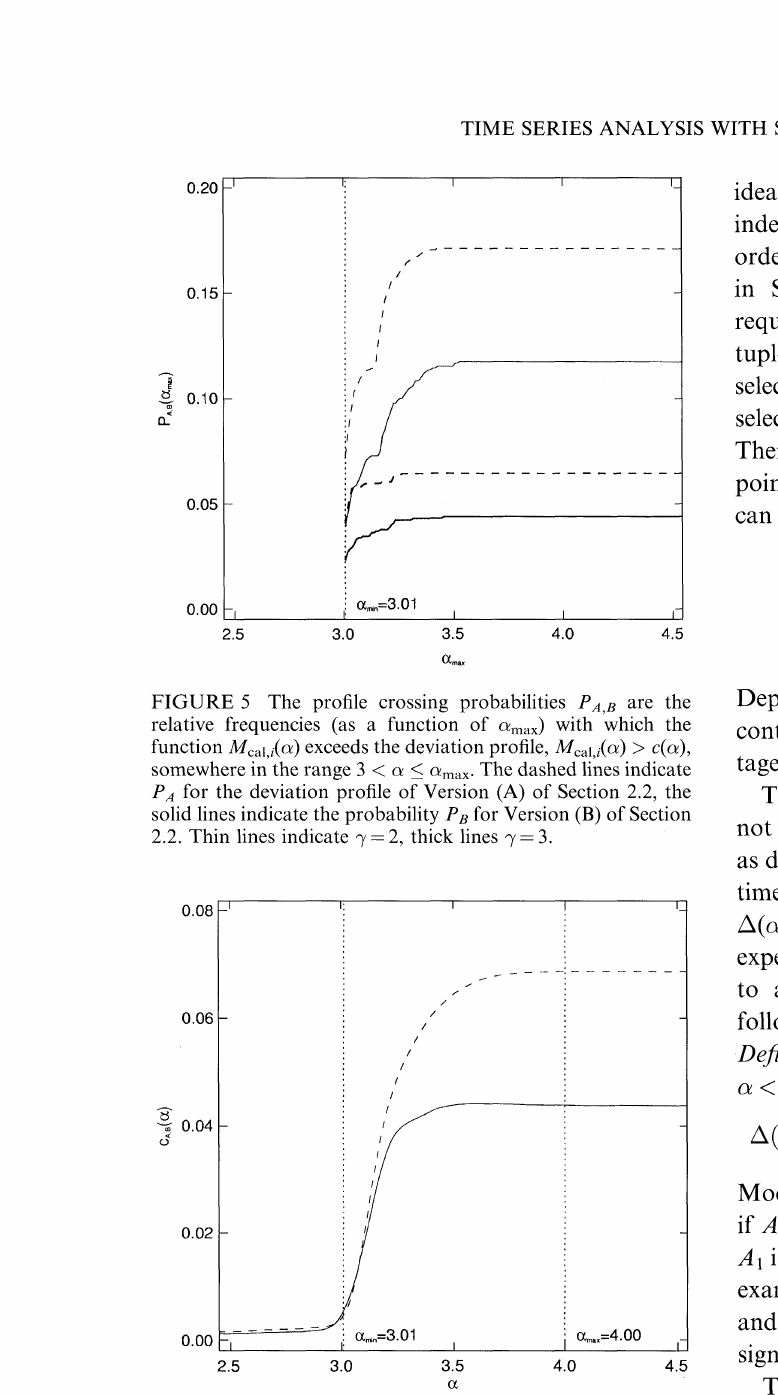
FIGURE 6 Deviation profiles CA(a) (dashed line) and cB(a) (solid line) according to Versions (A) and (B) of Section 2.2. ratio is defined as the relative number of data points x(t) due to the non-random